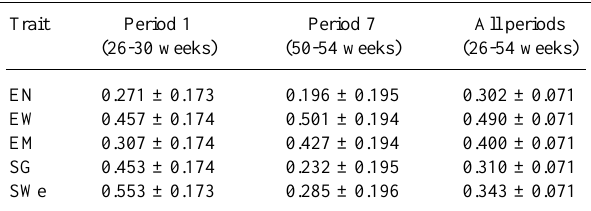
Table II Heritability estimates for egg traits of White Leghorn hens.